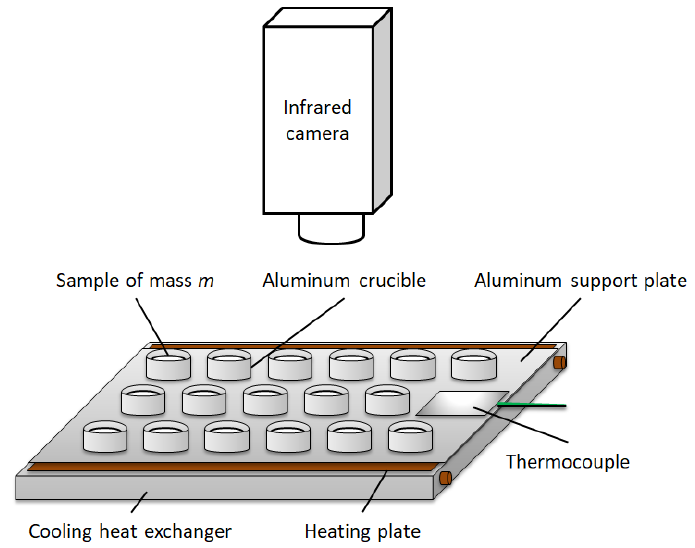
Figure 1. Scheme of the experimental setup.